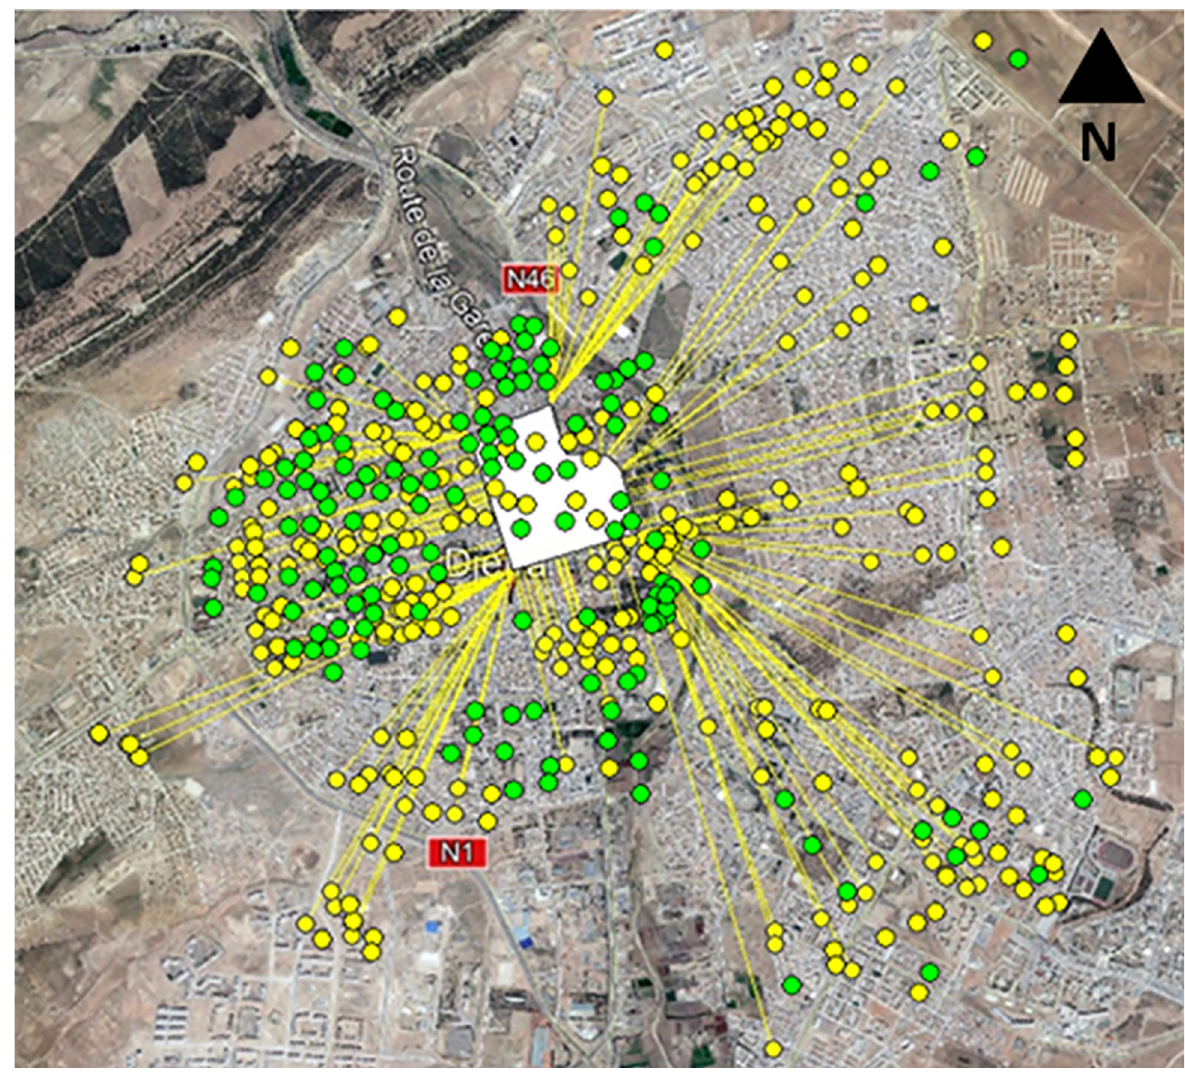
Fig. 5. Employment and housing locations. green: workplace, yellow: housing, white: centre of the